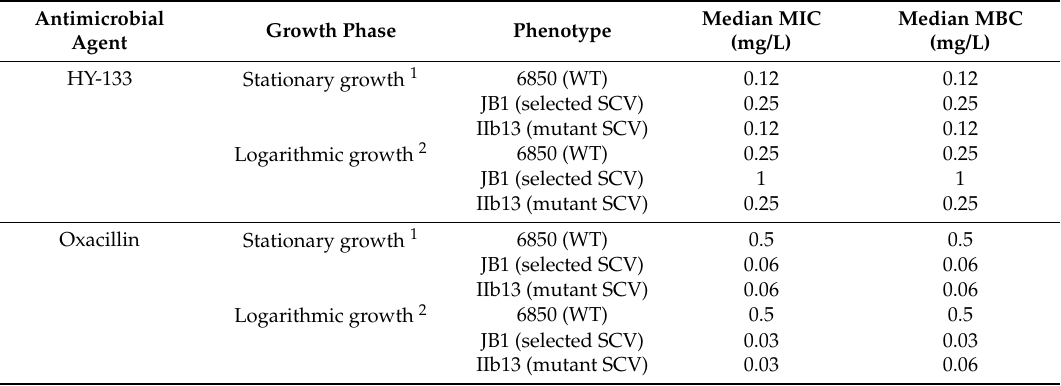
Table 2. Comparison of antimicrobial activities of HY-133 and oxacillin against WT strain 6850, its gentamicin-selected SCV JB1, and its hemB mutant SCV